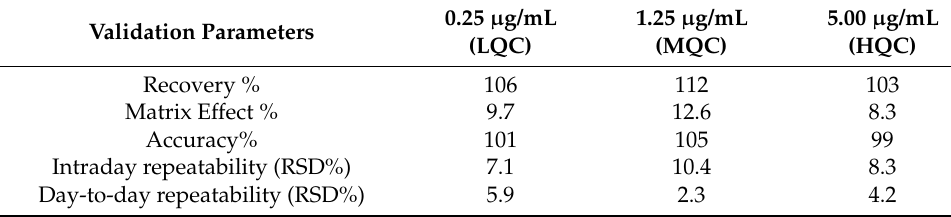
Table 1. Validation parameters evaluated in three different concentrations (LQC, MQC, HQC) of fortified blood sample with lidocaine.